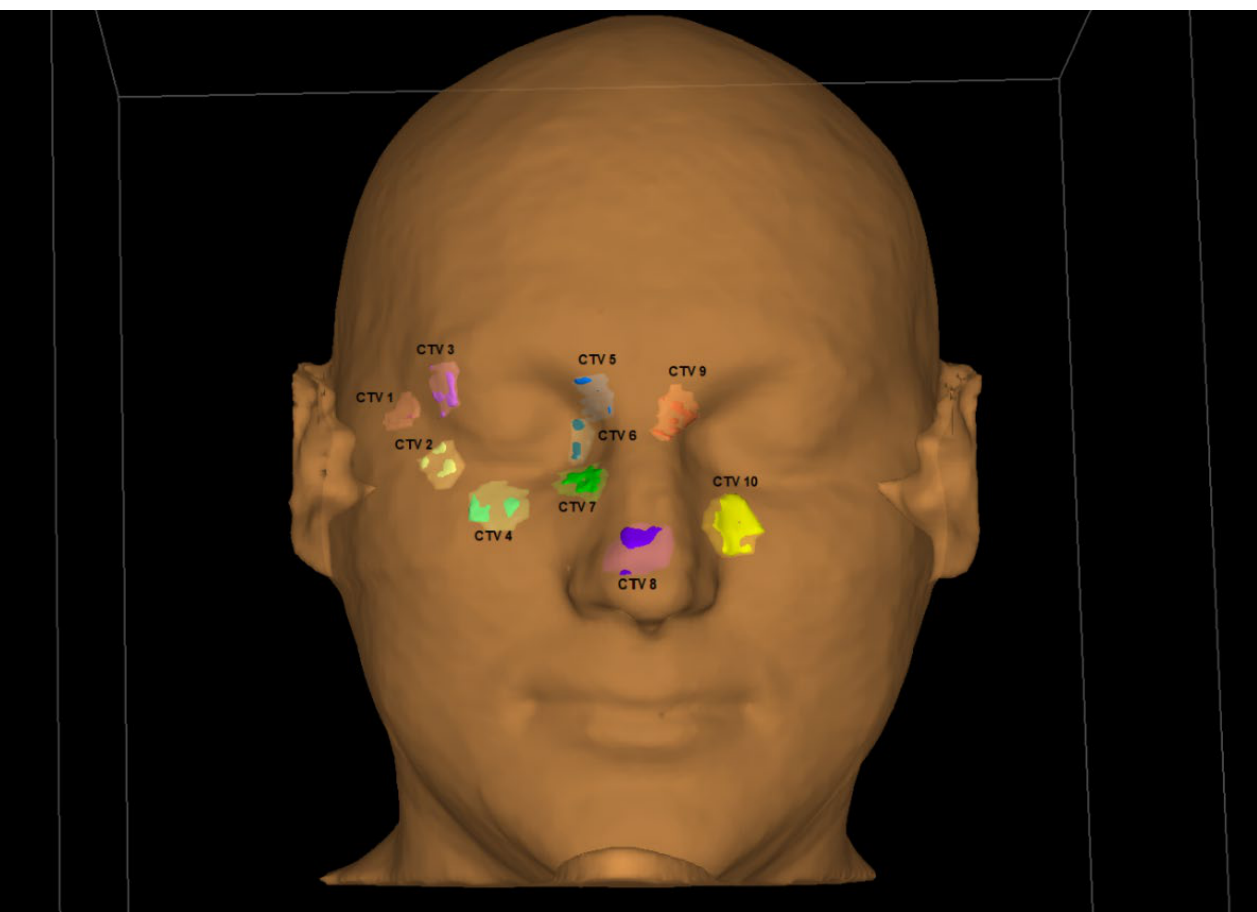
Figure 6. The location of the target areas (CTV1-CTV10) used for preparing the treatment plans.